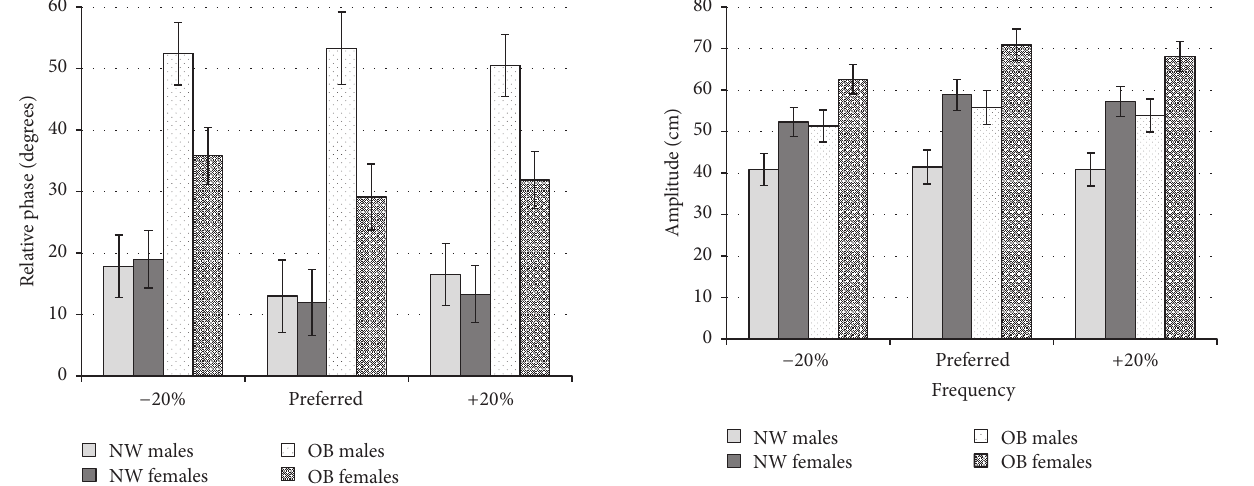
Figure 4: Mean amplitude values over which participants swung the pendulum shown for normal weight (NW) and obese (OB) participants divided by gender for all 3 frequency conditions ( − 20%, preferred frequency, and +20%).